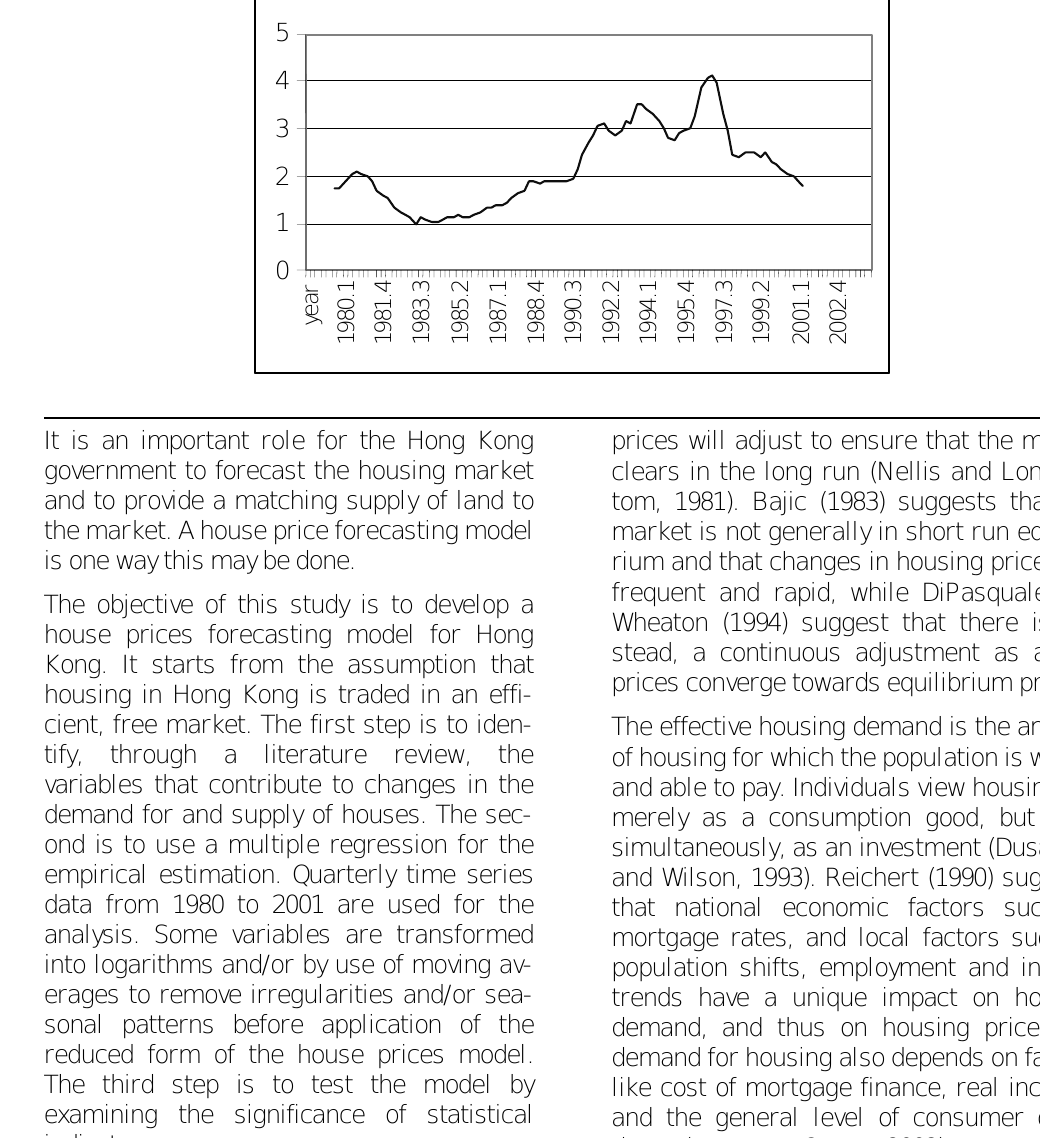
Figure 1: Real Residential Housing Prices Index in Hong Kong (Source: Rating and Valuation Department, Hong Kong Government) Real